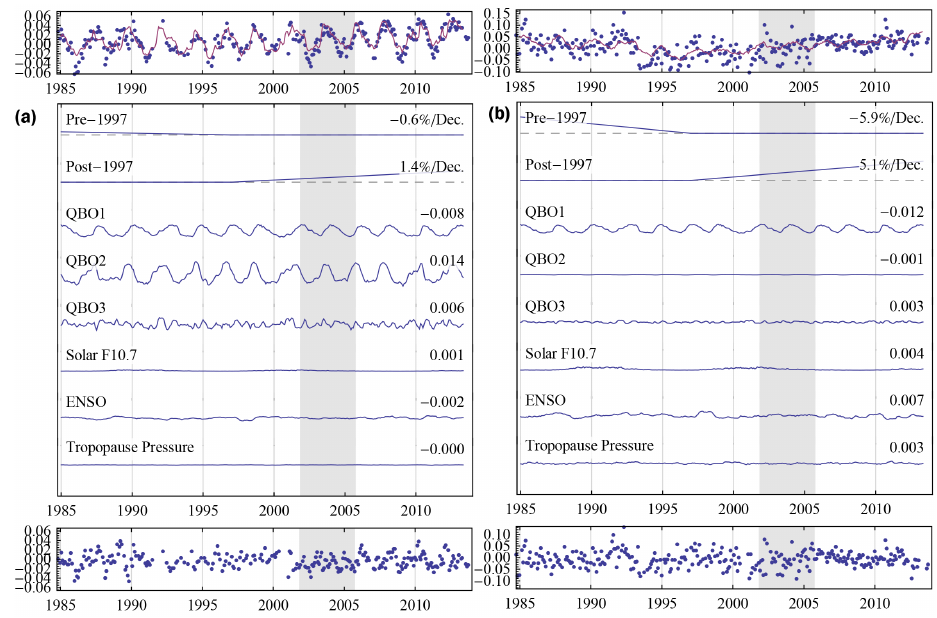
Figure 7. Same as Fig. 6. Left: 5 ◦ S–5 ◦ N at 27.5km altitude (cf. Figs. 1c, 3c). A small positive linear trend is observed after 1997. The QBO indices are the dominant terms. Right: 25 ◦ S–15 ◦ S at 44.5km altitude (cf. Figs. 1d, 3d). Significant recovery of 5.1% per decade is observed after 1997 following a decrease of − 5.9% per decade prior to